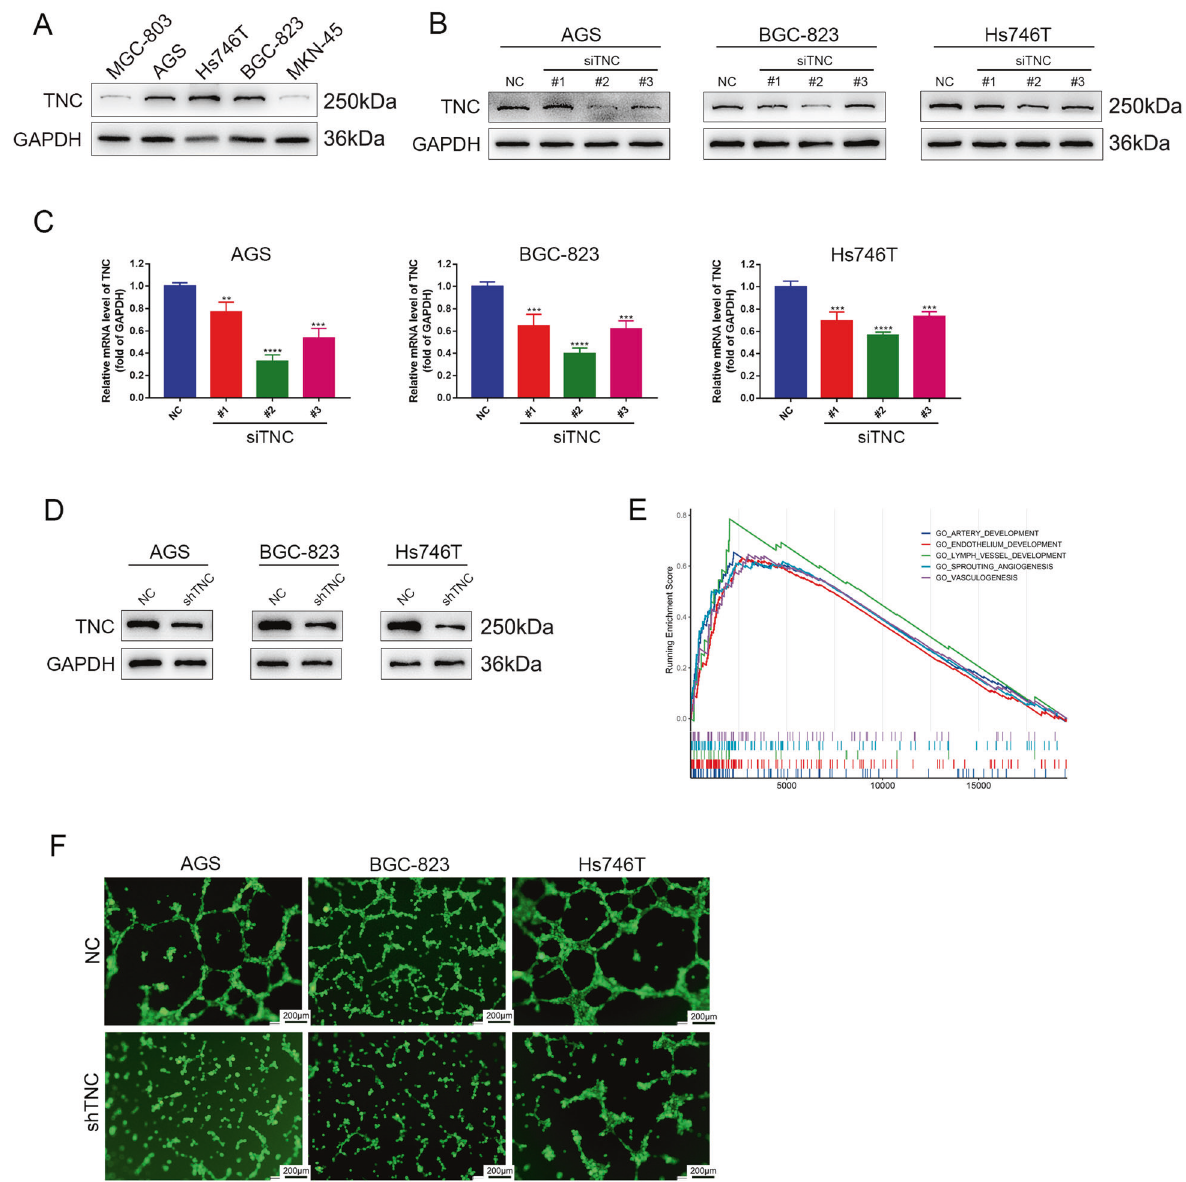
Fig. 2 Construction of cell lines and TNC knockdown attenuated VM formation in vitro. A Western blot of TNC protein and gene expression in four gastric cancer cell lines; GAPDH was used as a loading control; protein ( B ) and gene ( C ) expression levels of TNC in AGS, BGC-823 and Hs746T cells transfected with siRNA targeting TNC. D Western blot analysis of knockdown ef fi ciency of shTNC. E Bioinformation analysis of TNC functions. F VM was signi fi cantly reduced in AGS, BGC-823 and Hs746T cells after transfection with TNC shRNA. Results were shown as mean ± SD of three independent experiments; each experiment was performed in triplicate. ** P < 0.01; *** P < 0.001; **** P <